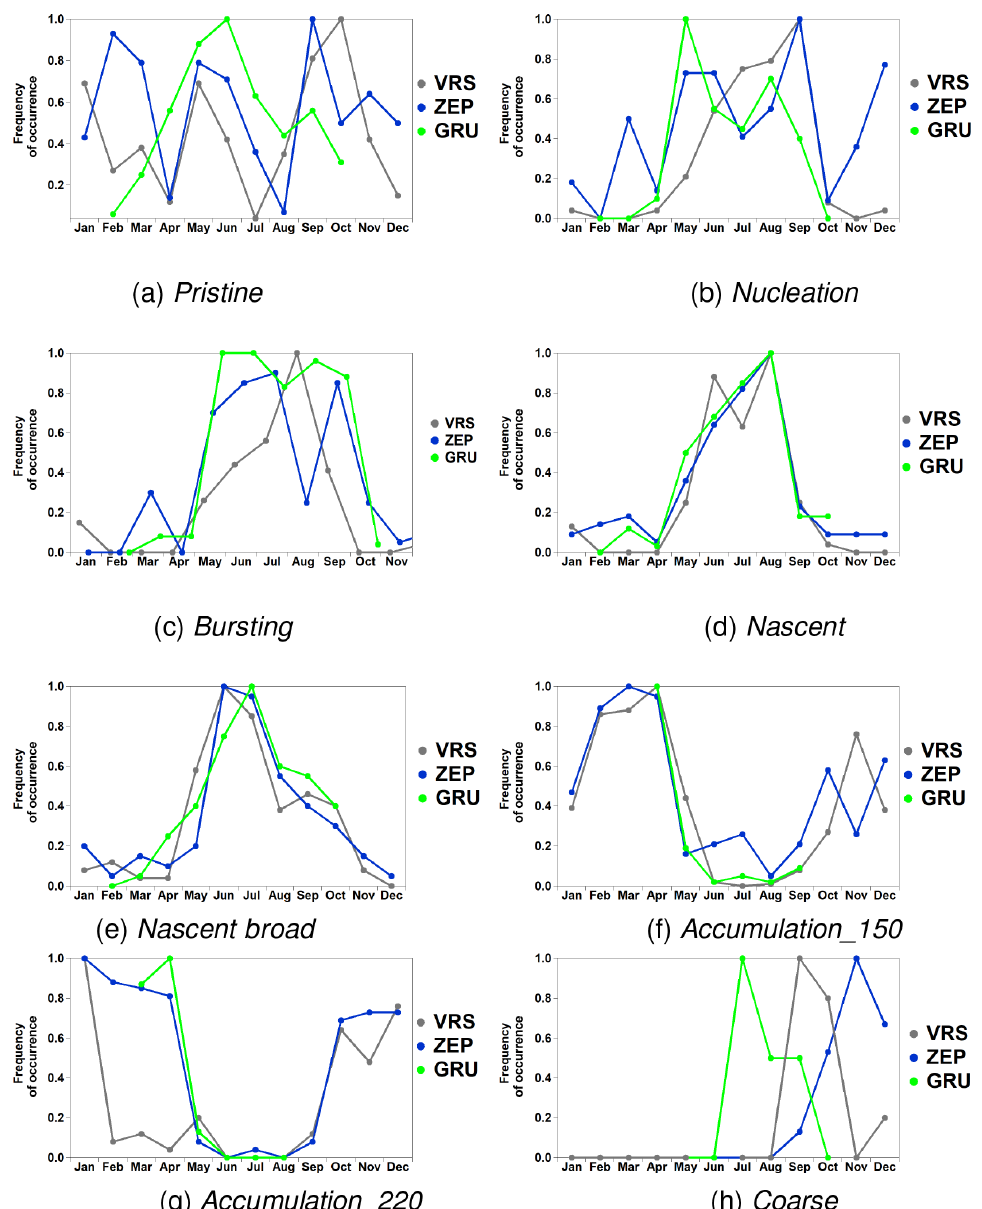
Figure 4. Monthly occurrence of each size distribution category (a–h) over the entire available data period (2013–2015), at each measurement site (VRS, ZEP, GRU), reported as total counts, relative to the maximum frequency of